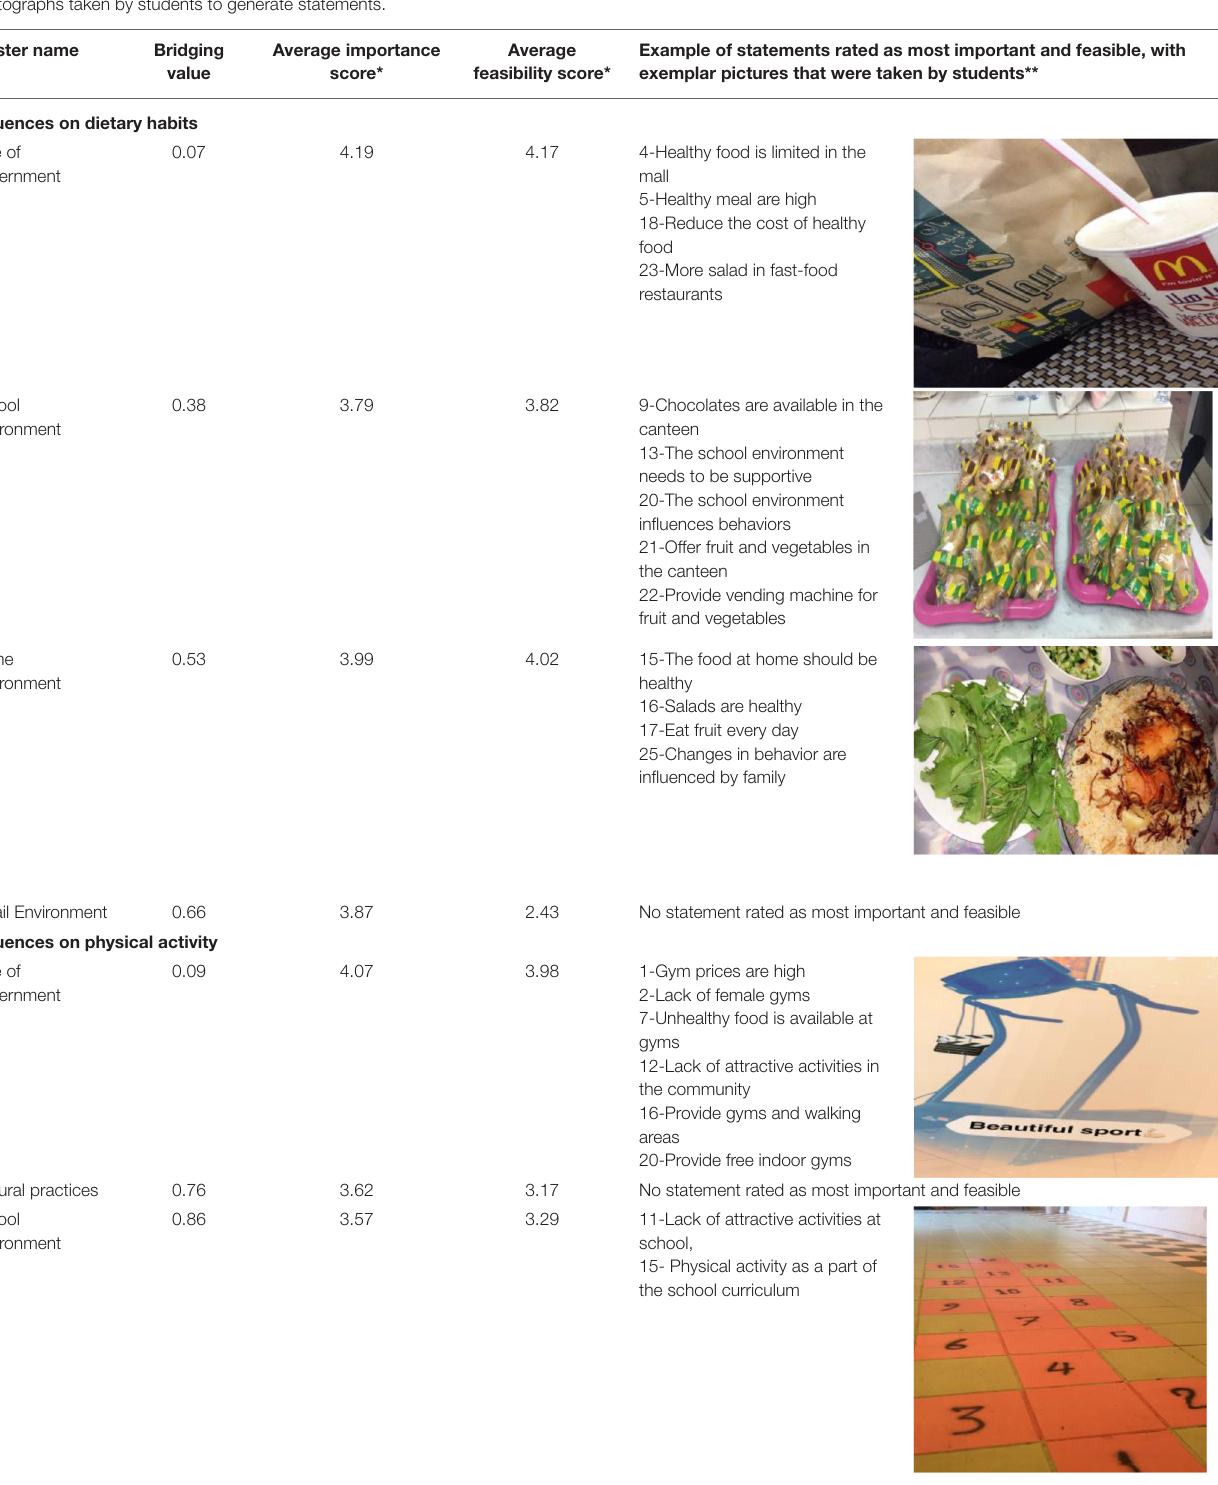
* Score out of 5. ** Derived from the upper right quadrant of the Go-Zone